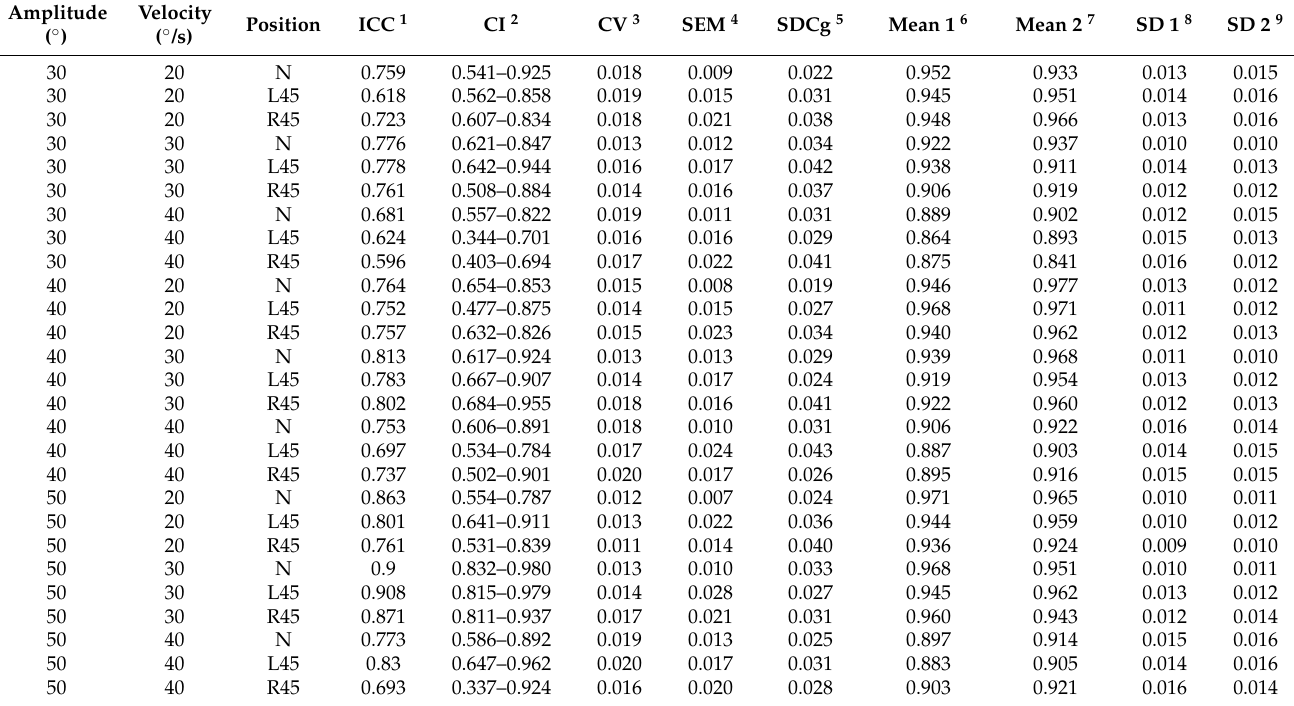
Table 1. Average gain reliability for each task in healthy